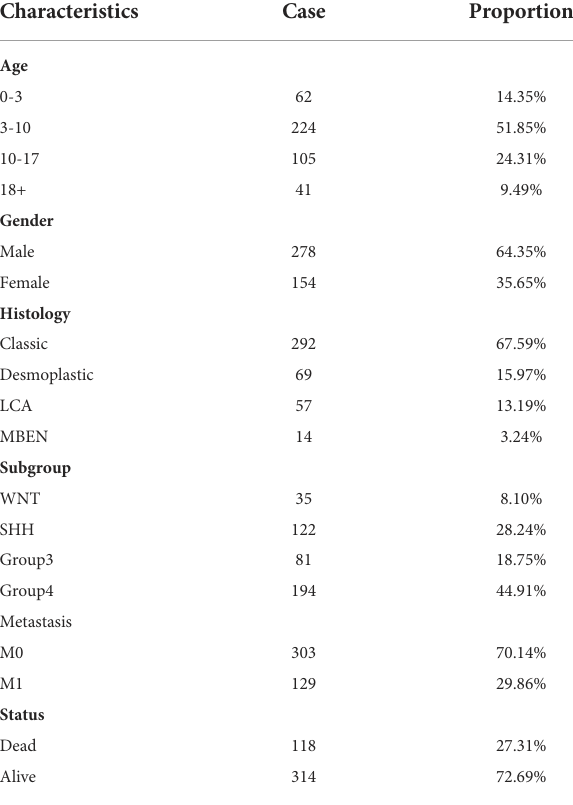
TABLE 2 The characteristics of of MB patients in GSE85217 dataset.